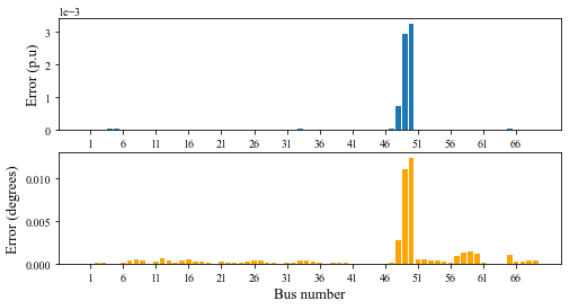
Figure 16. State estimation error (OP)—69-bus system, N m = 4.